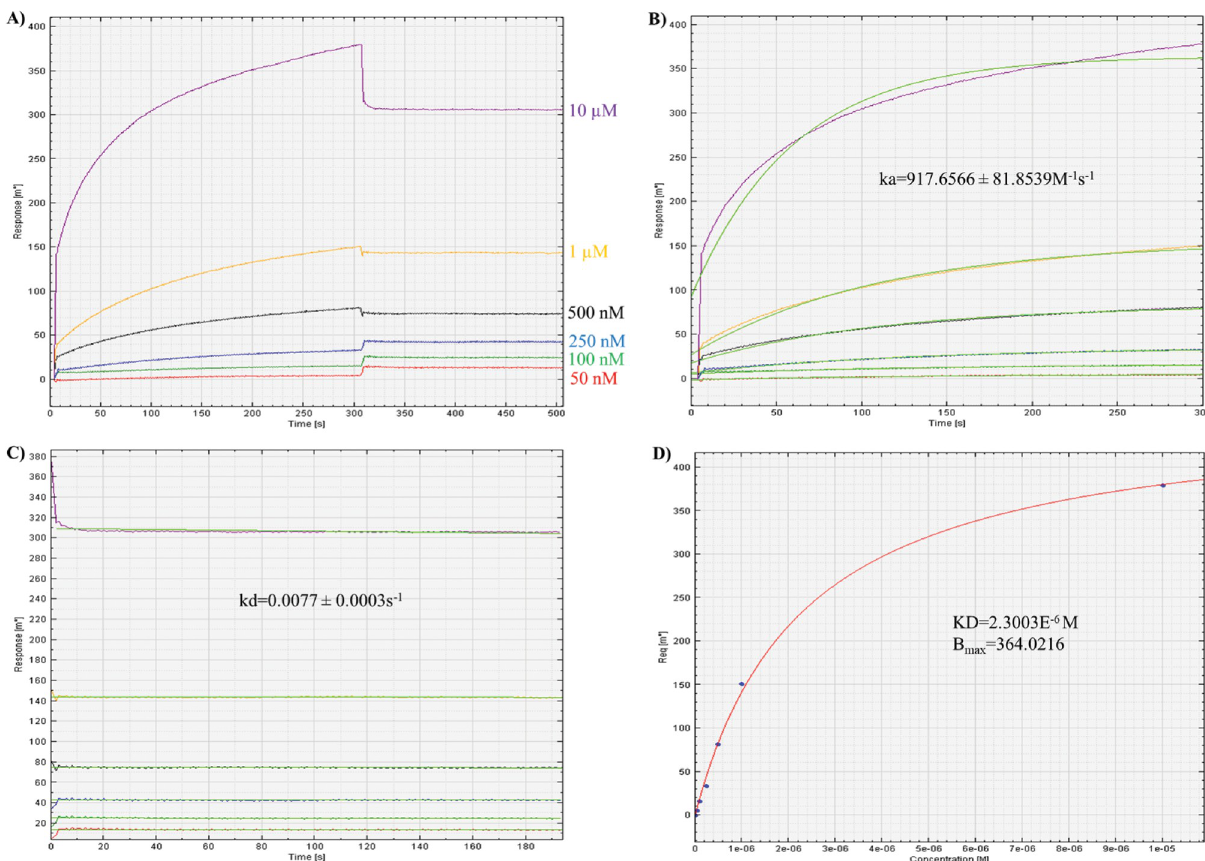
Fig 4. Measurment of scFv affinity to FuBc by using SPR association and dissociation kinetics. A) Sensorgram was achieved by applying scFv in mobile phase at different concentration starting from 10 μ M to 50 η M over the stationary phase of FuBC. B) Association constant ( k a ) was calculated by measuring k kinetics from association curve. C) Dissociation constant ( k on /k off Finally, scFv affinity constant ( K D ) was calculated by measuring k d /k a kinetics from affinity